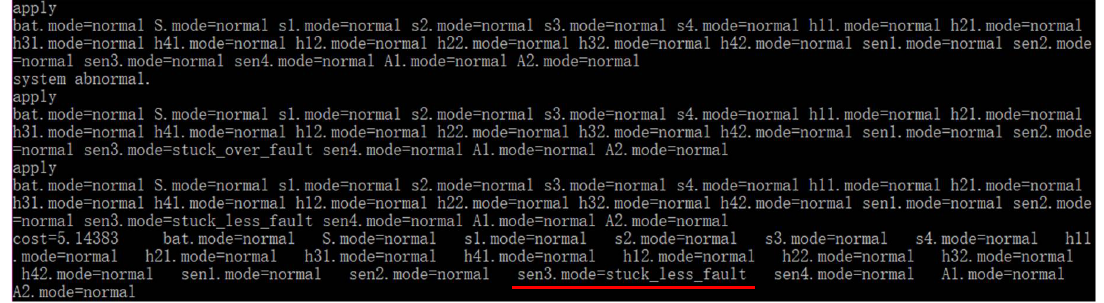
Figure 15. Diagnosis Process of CCDLSA* for Single Diagnosis.